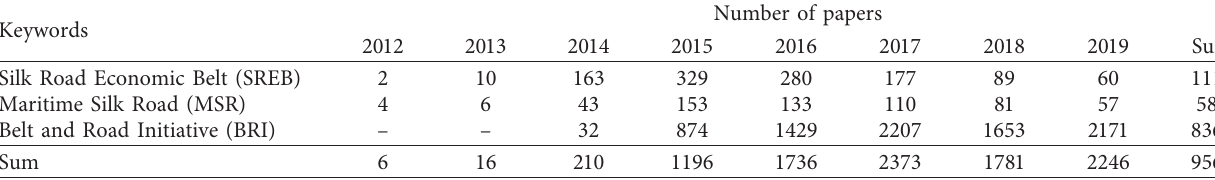
Table 1: Number of papers on the Belt and Road in China’s CSSCI journals.